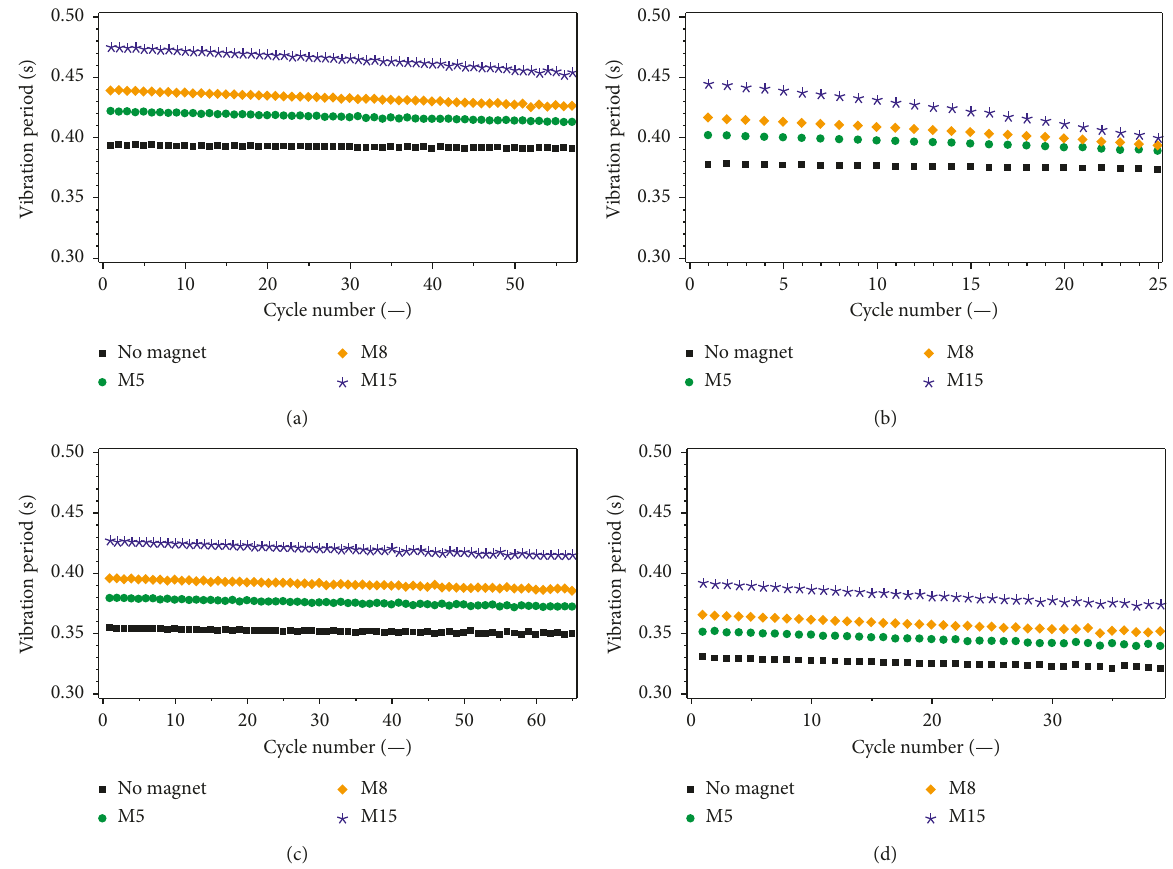
Figure 9: Vibration period of subsequent cycles: (a) MRE 1A, (b) MRE 1B, (c) S